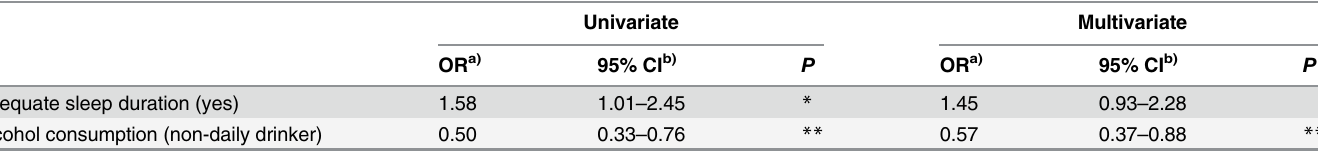
Table 6. Factors associated with therapeutic failure in patients with cerebrovascular and/or coronary artery disease (n = 409) (logistic regression